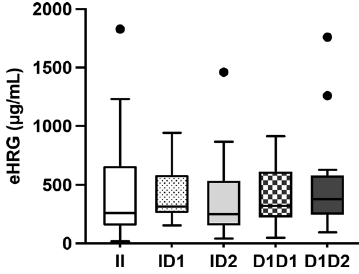
Figure 5. Plasma levels of eHRG protein. Plasma levels of eHRG were measured by an ELISA. Obtained data were shown using a box plot that is composed of the median (solid line in each column), upper hinge, lower hinge, whiskers representing upper adjacent value or lower adjacent value. Black dots above columns indicate far out values. N = 20 in each group. II: Insertion/insertion, ID1: insertion/45 bp deletion, ID2: insertion/ 90 bp deletion, D1/D1: 45 bp deletion/45 bp deletion, D1D2: 45 bp deletion/90 bp